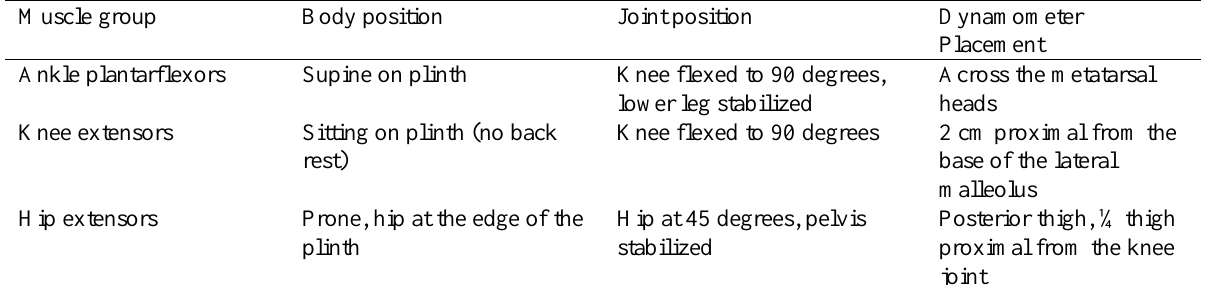
Table 2 Isometric strength test positions Muscle group Body position Joint position Dynamometer Ankle plantarflexors Supine on plinth Knee flexed to 90 degrees,